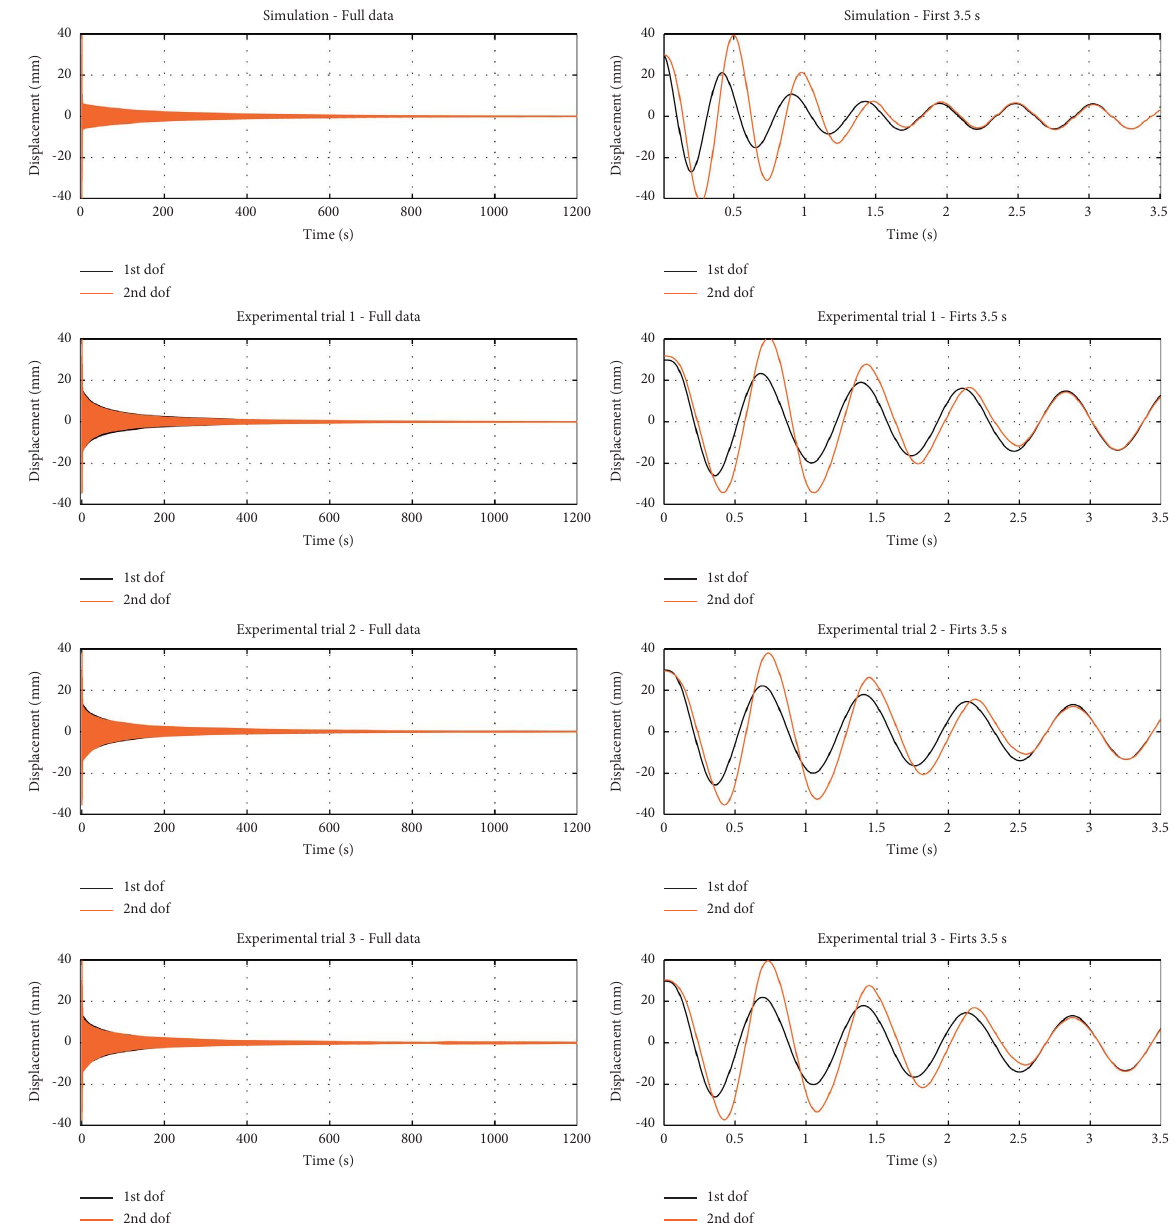
Figure 12: Real and simulated data of time response with TMD. Second model with